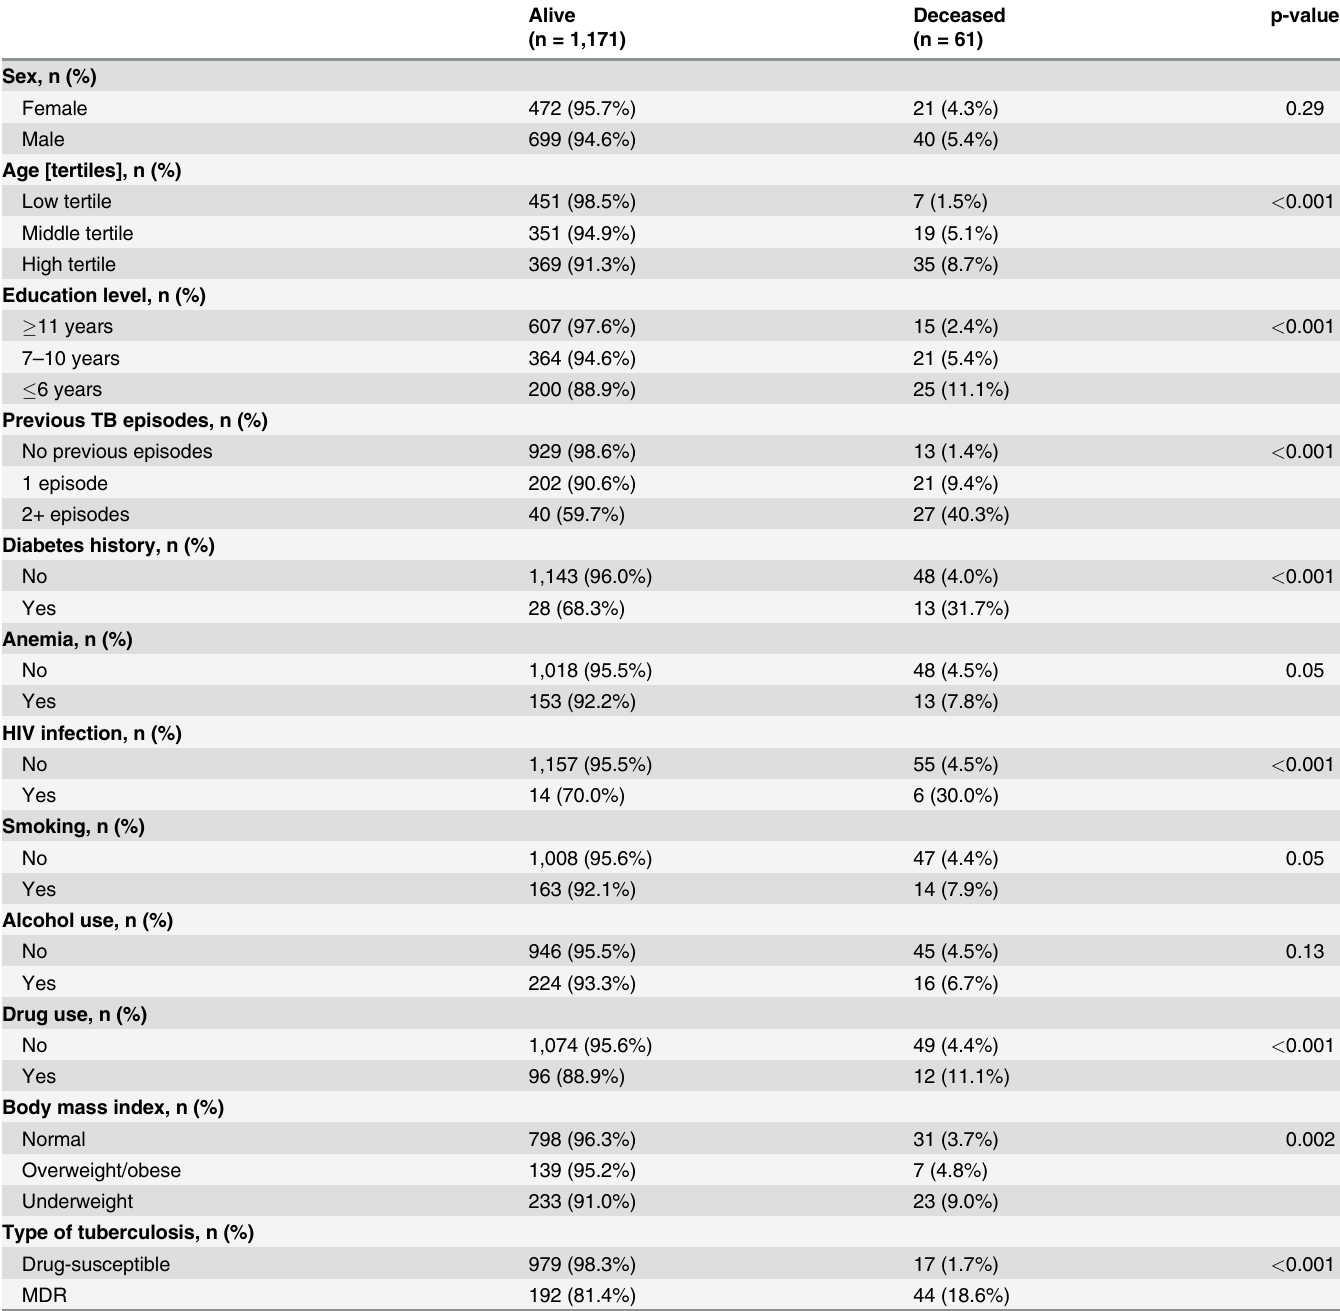
Table 1. Population characteristics according to the outcome of